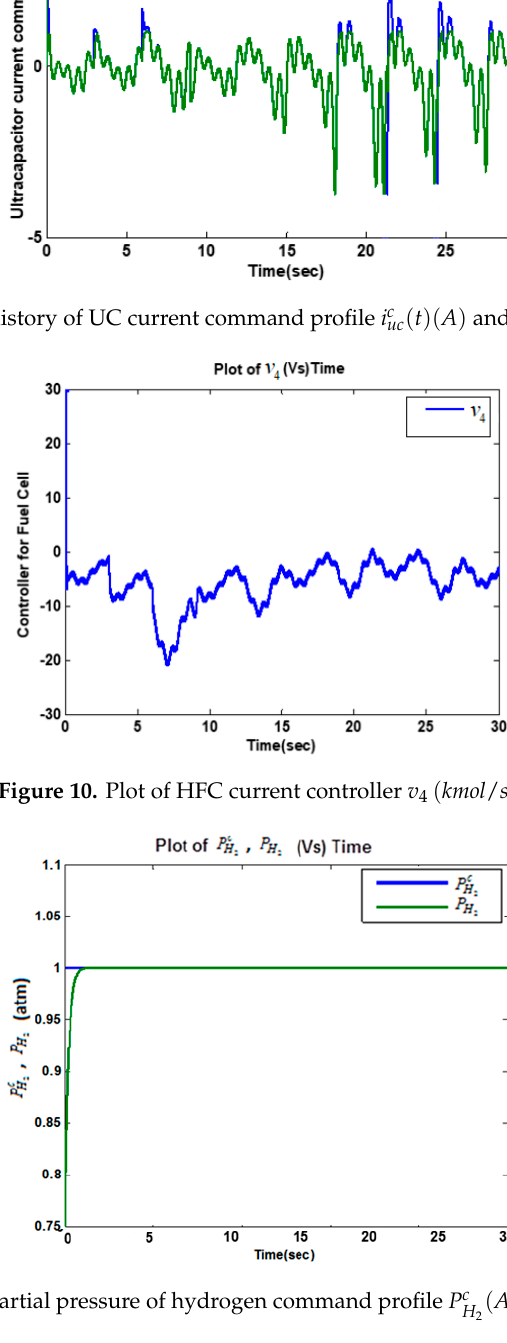
( Atm ) and hydrogen partial H 2